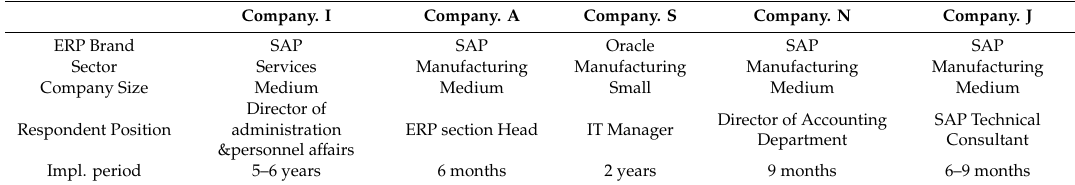
Table 1. A summary of companies’